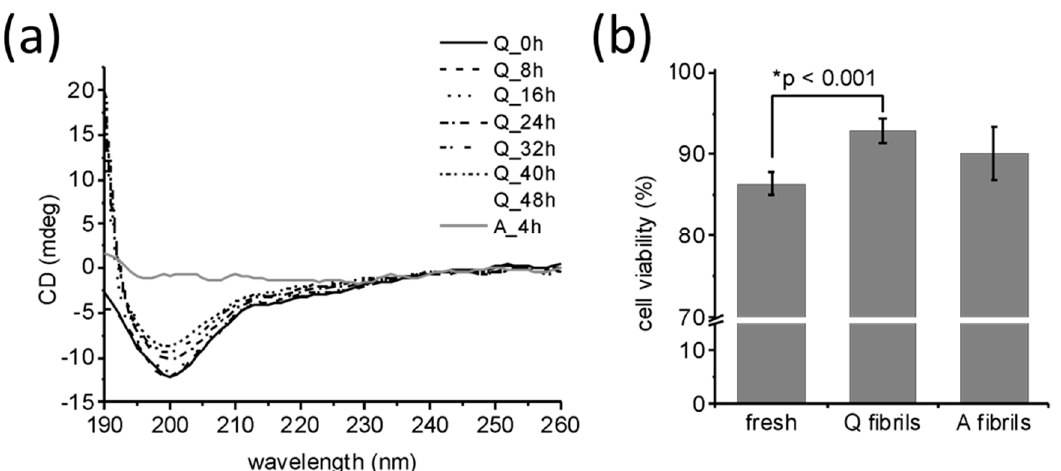
Figure 4. Properties of fibrils formed under quiescent and agitated incubation. ( a ) Circular dichroism (CD) shows that following incubation of medin for 48 h under quiescent (Q) conditions there is still a CD signal remaining (dashed line), whereas incubation under agitated (A) conditions has no detectable CD signal remaining (dotted lines). Analysis of the spectra using CONTINLL suggests that quiescent fibrils have increased β -sheet structures compared to freshly prepared medin (Table 1). ( b ) Cell viability of human aortic smooth muscle cells (HAoSMC) after exposure to freshly prepared and aggregated medin, as determined by Cell Counting Kit-8 (CCK-8) assay; mean ± SEM is shown for n = 5. There is no statistical difference between A and Q fibrils assessed by t -test.